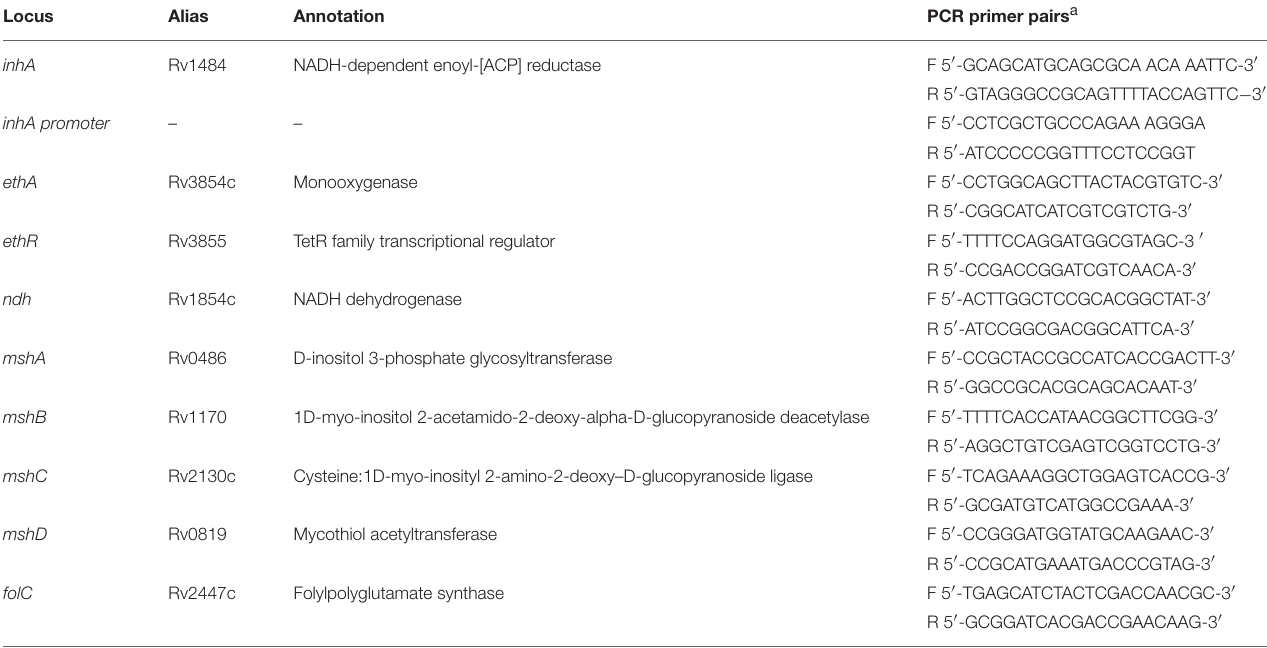
TABLE 1 | Candidate genes conferring PTH resistance in Mycobacterium tuberculosis .